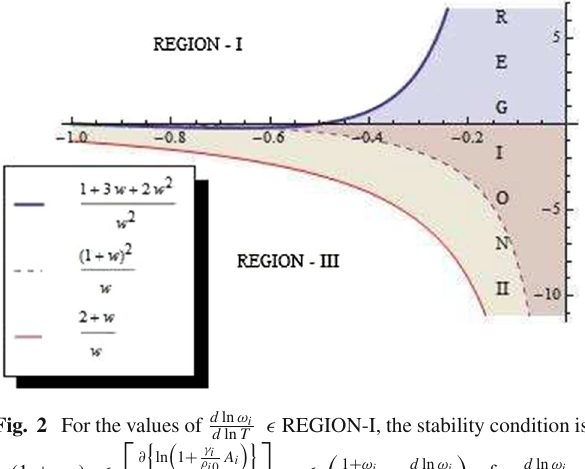
(cid:11) REGION-I, the stability condition d ln T